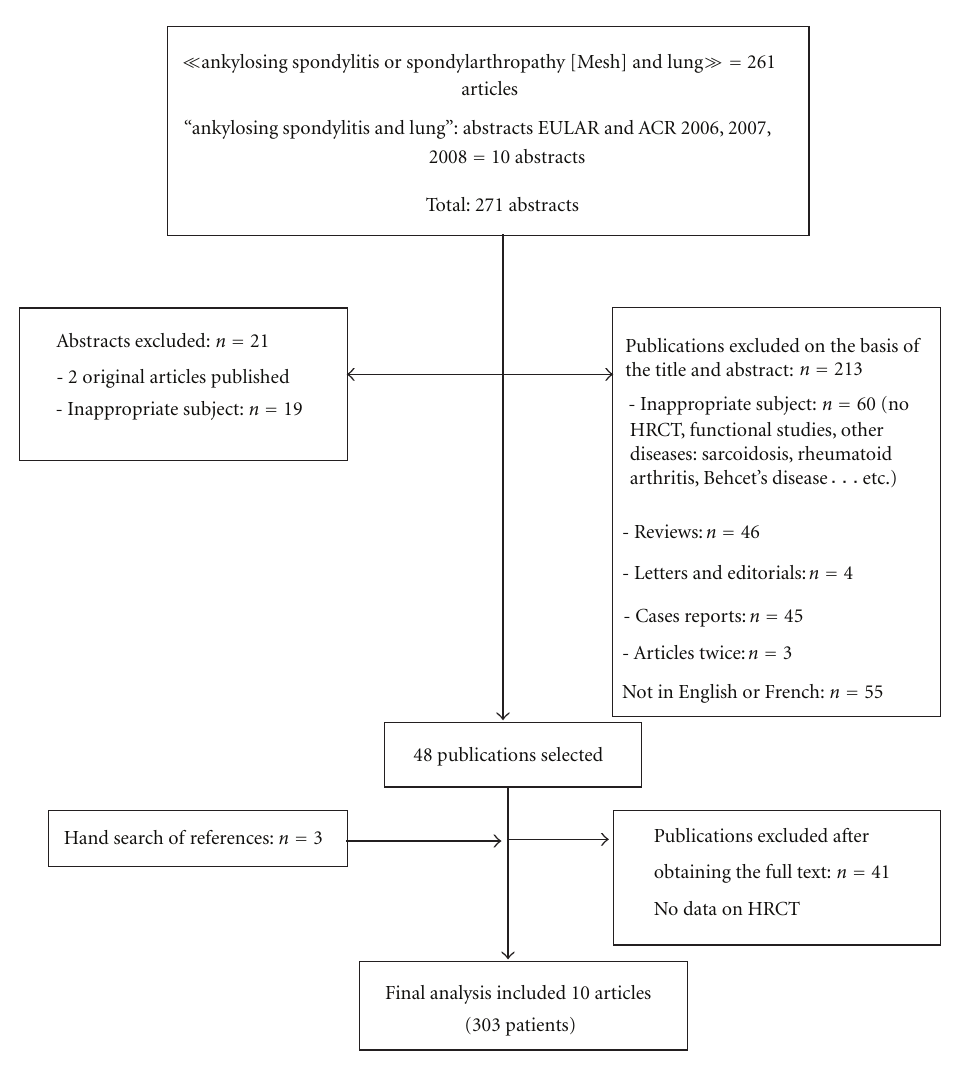
Figure 1: Flowchart summarizing the search